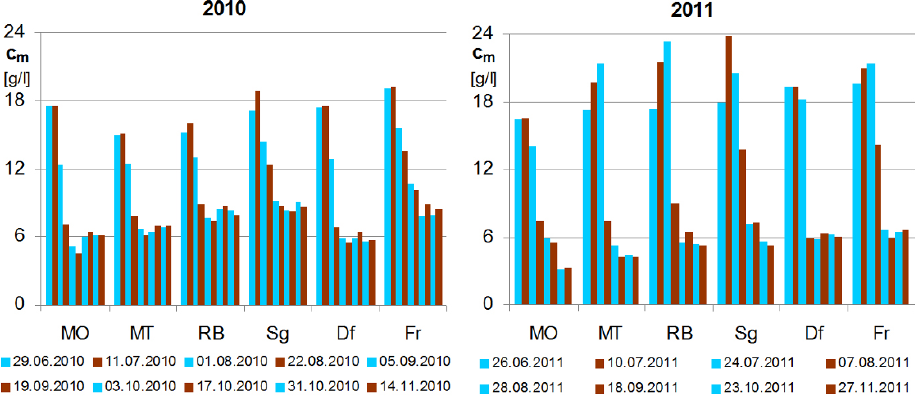
Figure 5. Comparison of tartaric acid contents changes in grapes of the studied varieties in 2010 and 2011: Muscat Ottonel (MO), Müller-Thurgau (MT), Pinot Blanc (RB), Sauvignon (Sg), Dornfelder (Df), and blue Frankish (Fr).